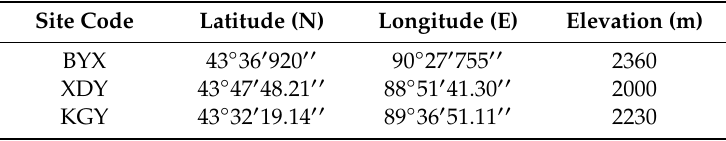
Figure 1. Map of sampling sites, meteorological station, hydrological station and main rivers in central Tien Shan, China. Table 1. Information about the sampling sites in the Kaiken River